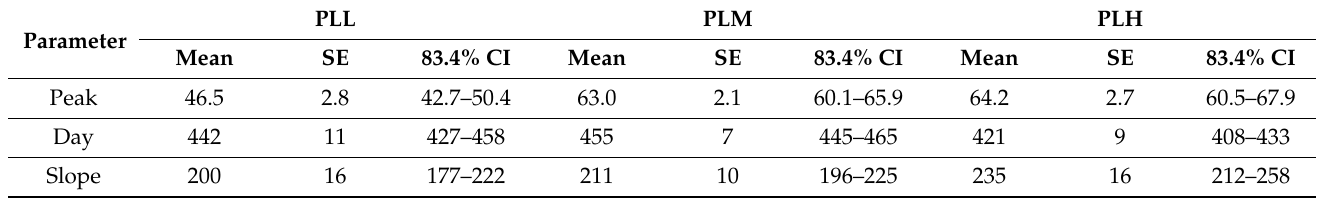
Table 4. Mean, standard error (SE), and 83.4% confidence interval (CI) of Gaussian models to estimate plantain percentage from day 150 to 705 after sowing for PLL, PLM, and PLH.